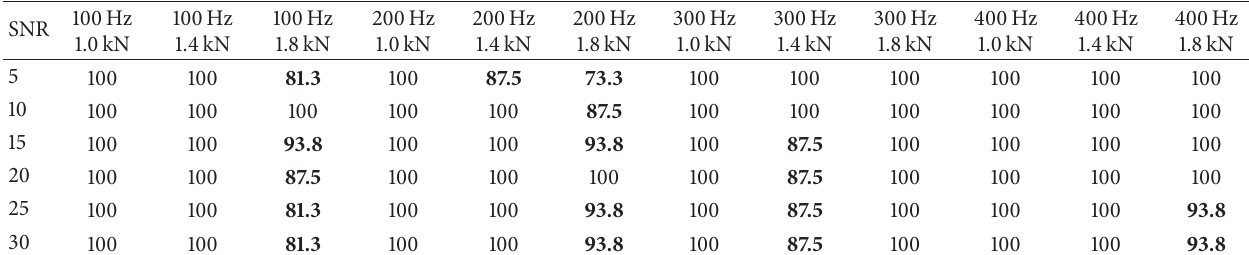
Table 2: The success rates of damage detection using the proposed algorithm (PIEEMD) in 𝑌 direction.